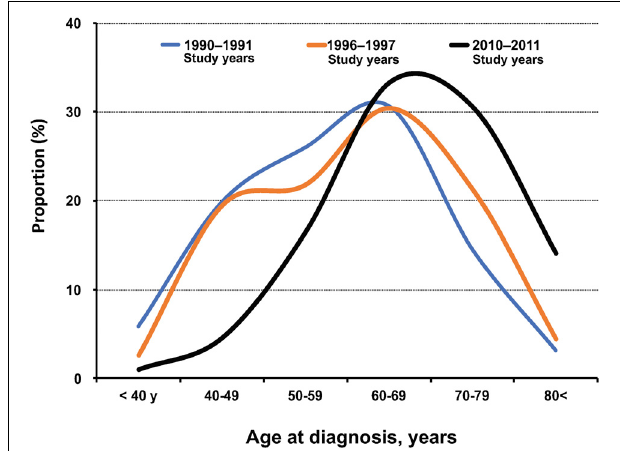
FIGURE 2 | Summary of age at diagnosis of ATL by study year (1990–92, 1996–97, and 2010–11) in Japan in literature. The data in each diagnosis period were cited from the